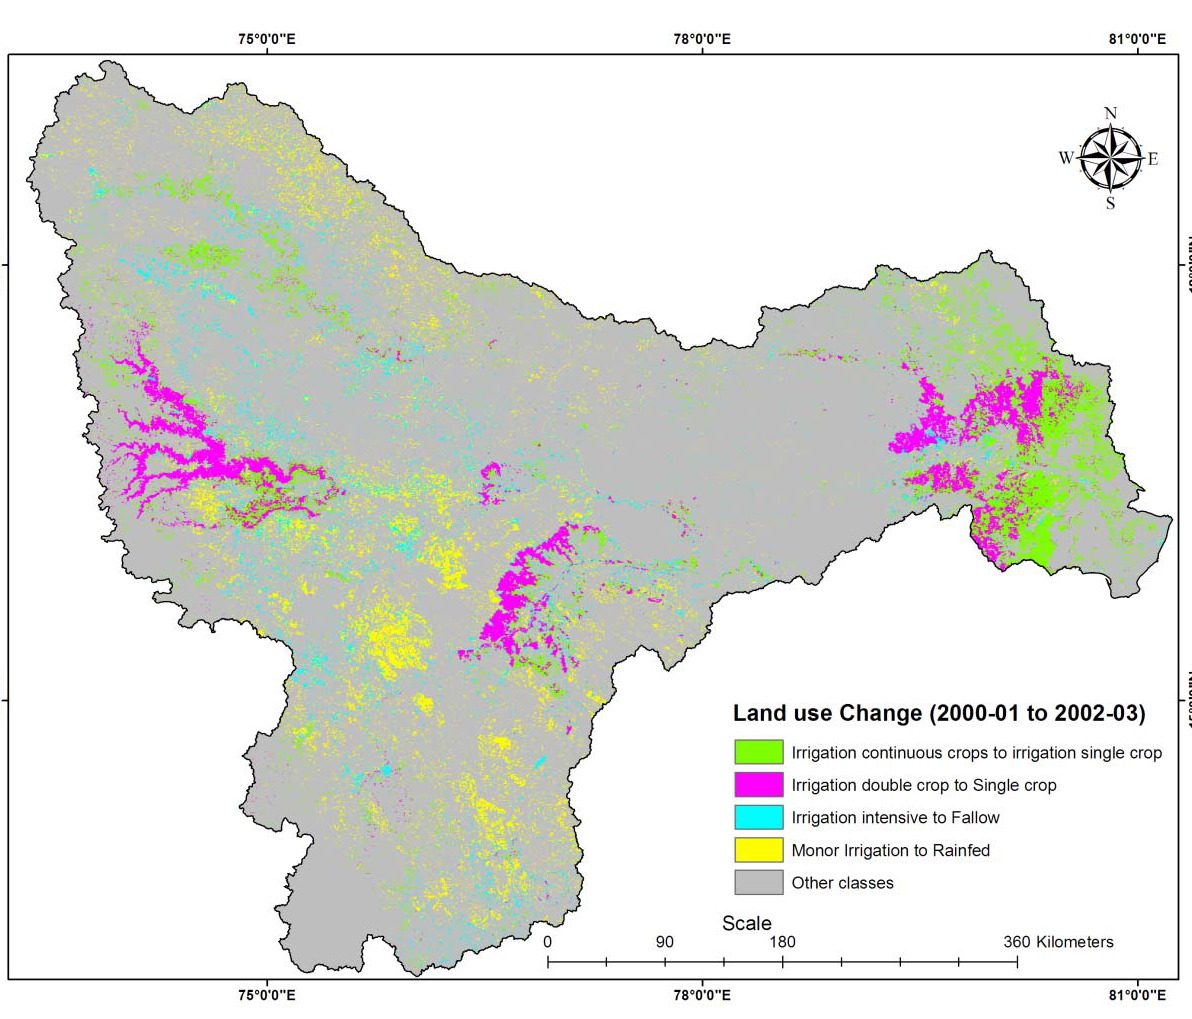
Figure 18. Food security in a changing water and climate scenario [112] . Irrigated cropland change map from 2000-01 (water-surplus year) when compared with 2002-03 (water-deficit year). Changes that occurred in a water-deficit year relative to a water-surplus year are shown in the map, including: (a) 1,078,564 hectares changed to single crop from double crop; (b) 1,461,177 hectares changed from continuous crop to single crop; (c) 704,172 hectares changed from irrigated single crop to fallow;